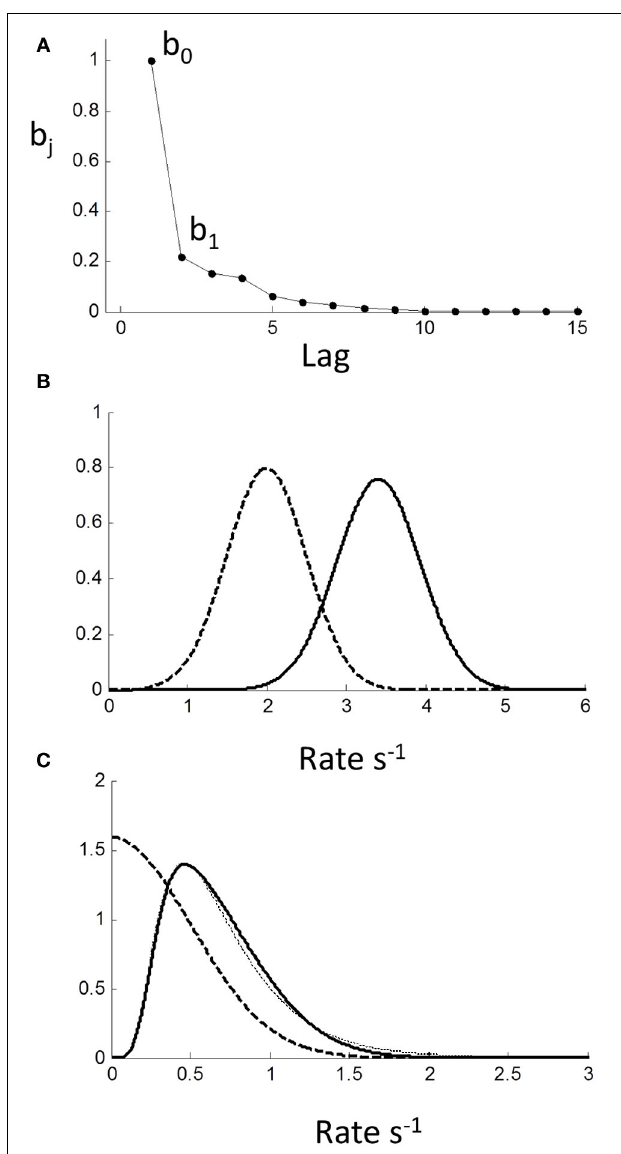
FIGURE 9 | Moving average (MA) model (Equation 1.2) computed from autoregressive coefficients using z-transform method (see Methods). (A) MA coefficients show extended dependency on lag indicating memory of input. (B) Effect of MA on a Normal input distribution with minimal truncation. Input ( μ = 2 ,σ = 0 . 3) (dashed curve) is shifted to higher rate (solid curve) with little change in shape; (C) Input is Normal ( μ = 0 ,σ = 0 . 3) truncated at 0. Note truncation is eliminated by smoothing. Resulting pdf could be mistaken for a reciprocal inverse Gaussian distribution (dotted